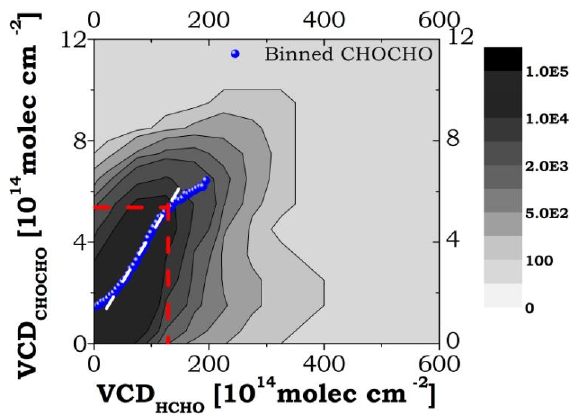
Figure 4 : Correlation plots of the regional averages of GOME-2 and SCIAMACHY R Fig. 4. Correlation plots of the regional averages of GOME-2 and SCIAMACHY R GF values (presented also in Table 2) coupled with their standard deviation. Figure 4a illustrates the correlation of GOME-2 R GF data with the respective SCIAMACHY data for the same period (2007–2008) while comparison with the SCIAMACHY period 2003–2007 is shown in Fig. 4b. Figure 4c compares directly the above correlation of GOME-2 R data with the respective SCIAMACHY data for the same period (2007- GF mentioned SCIAMACHY datasets. SCIAMACHY R GF values are about 8–9% higher than the respective GOME-2 ones while the two SCIAMACHY datasets show a 1:1 relationship indicating that the values did not change significantly over time. of HCHO (GOME-2 VCD HCHO = 1.11 × 10 16 molec cm − 2 )